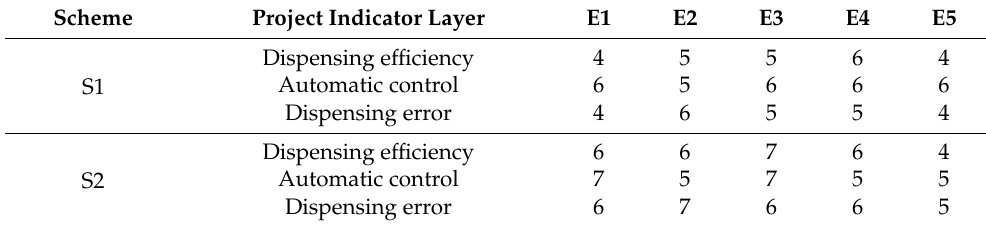
Table A1. Evaluation results of service performance.